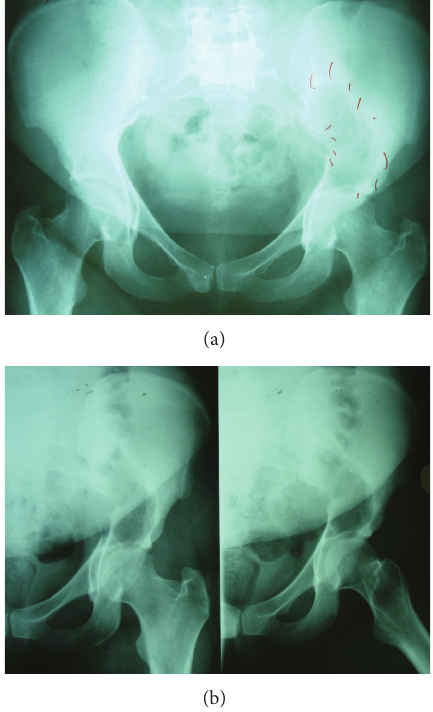
Figure 2: AP view of the pelvis showing a lucent lesion of the supra- acetabular area of the left iliac